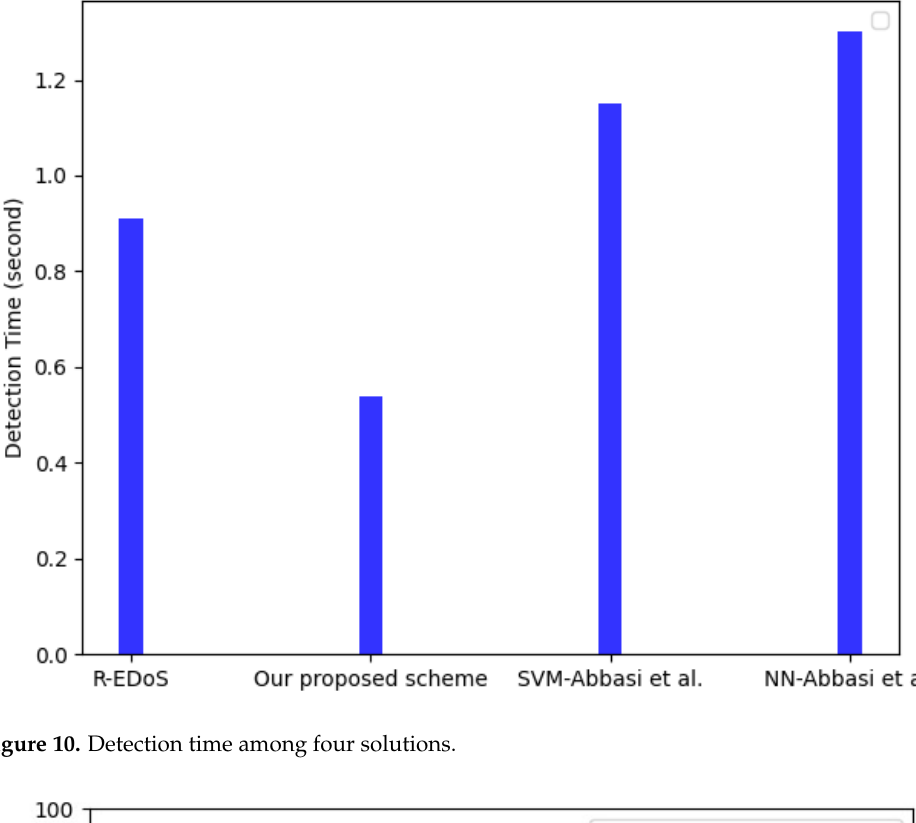
Figure 10. Detection time among four solutions.